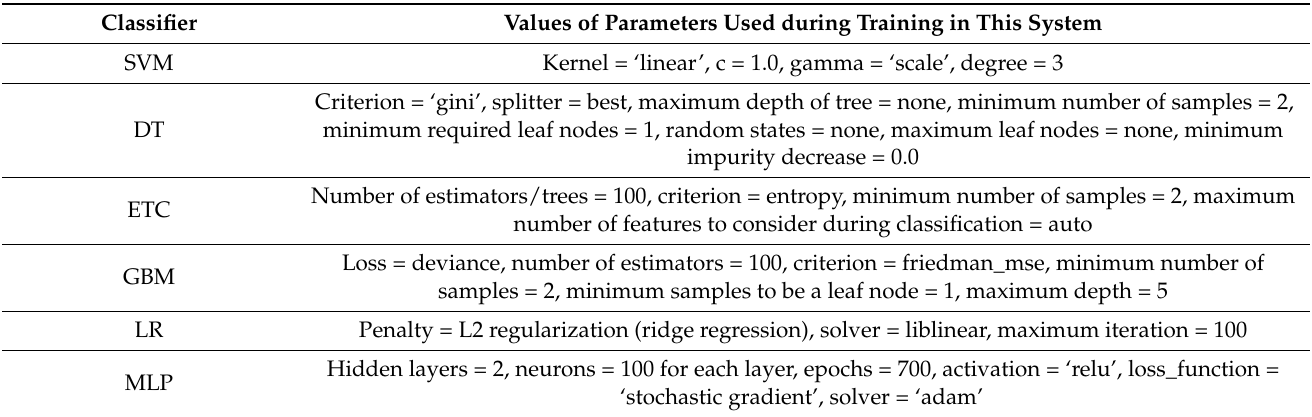
Table 3. Parameters used to tune